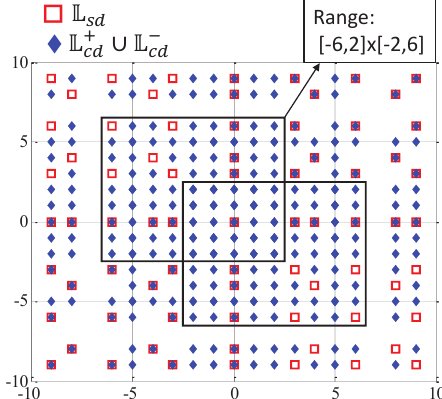
Figure 2. An example of the difference coarray of prototype planar coprime array (PPCA), where M 1 = 4 and M 2 =